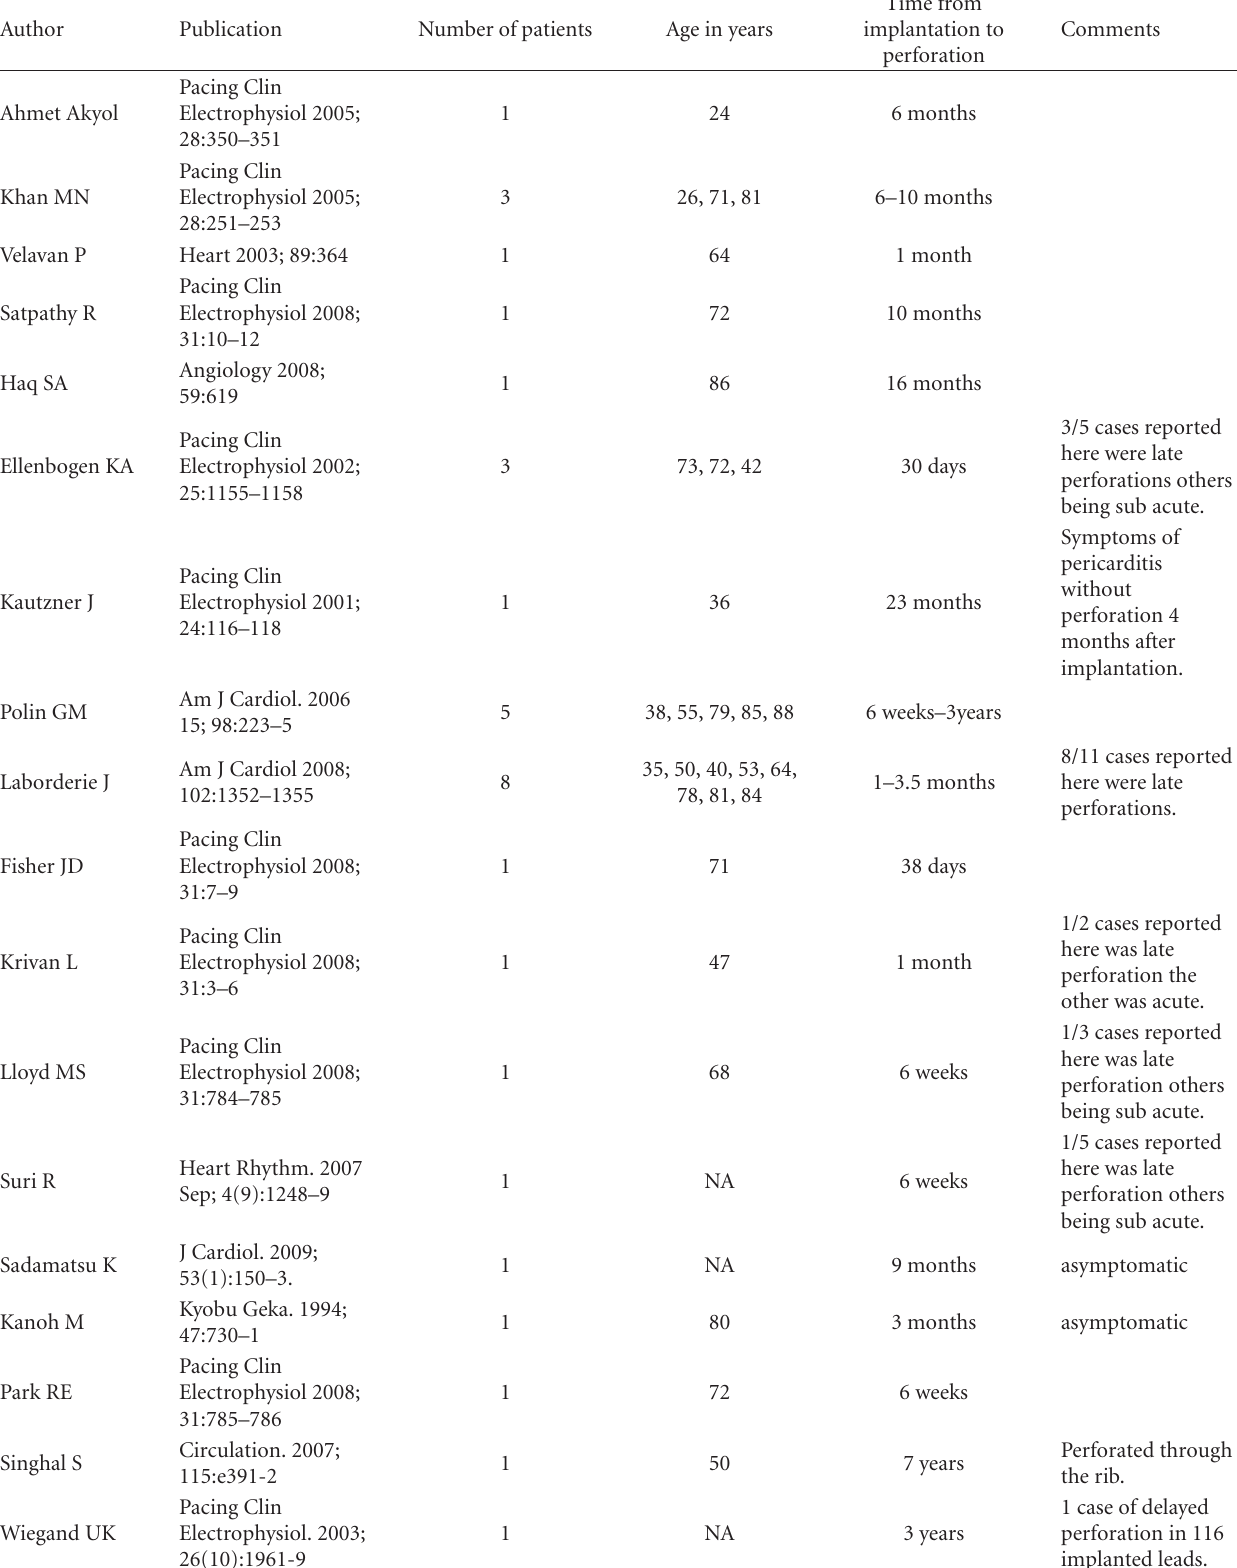
Table 1: Previously published cases of delayed lead perforation showing patient age and the delay from implantation to perforation.